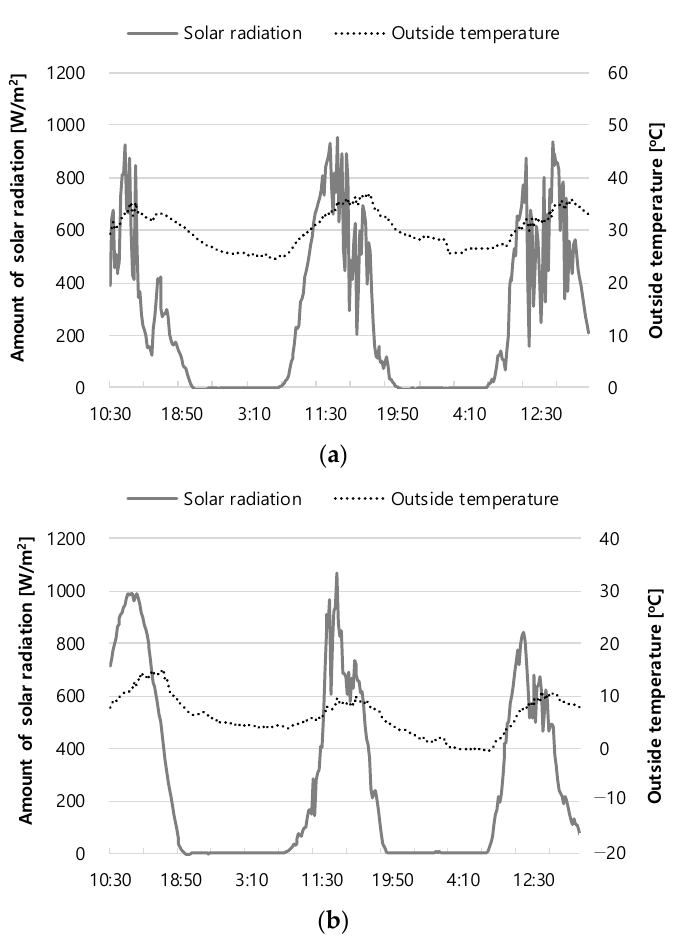
Figure 2. Solar radiation and outside temperature: ( a ) summer; ( b ) winter. In the case of PVT panels, where air can pass through the lower part of the panel, the temperature decreased by up to 7.6 ◦ C, compared to the existing PV at the top of the panel in summer, and the average temperature decreased by about 2.7 ◦ C during the period. This temperature decreased by up to 11.3 ◦ C and averaged 2.1 ◦ C in winter (Figure 3). In contrast, in the case of the lower panel temperature, the temperature change was relatively insignificant, with a maximum of 1.8 ◦ C and an average of 0.5 ◦ C in summer and a maximum of 0.6 ◦ C and an average of 0.1 ◦ C in winter (Figure 4). PV upper-side